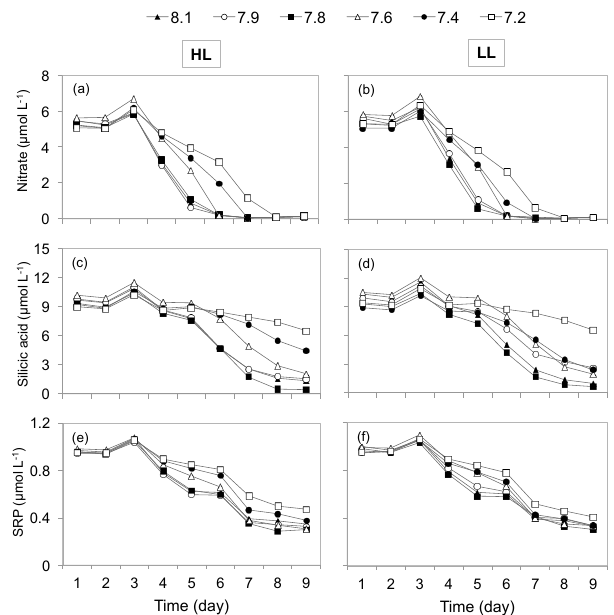
Figure 3. Temporal variations in (a, b) nitrate, (c, d) silicic acid, and (e, f) soluble reactive phosphate (SRP) concentrations during the experiment. Left and right panels show variations under the high light (HL) and low light (LL) treatments, respectively. Each curve represents a microcosm identified by its mean pH T value.